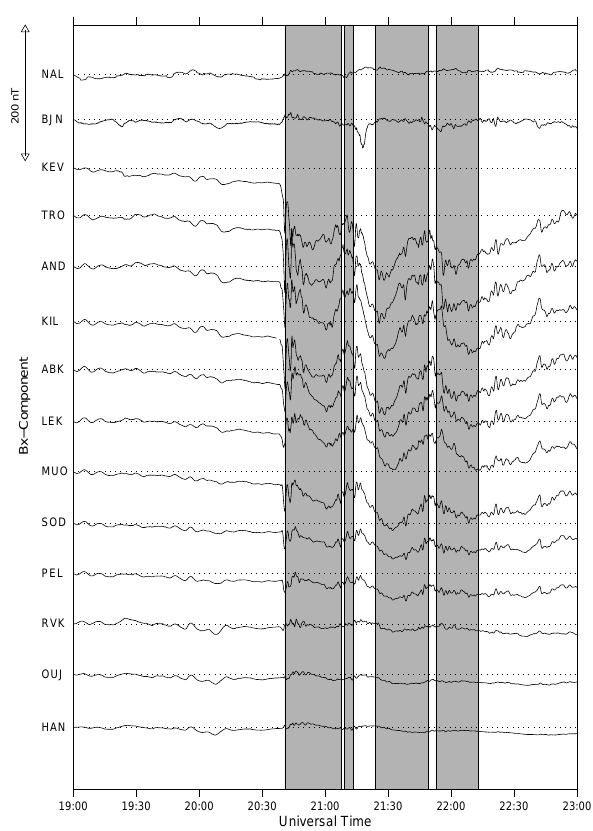
Fig. 5. Selected B x -component magnetograms from the IMAGE network. Periods during which Cluster is in the lobe have been shaded. Note that only s/c 2 is in the plasma sheet from 21:49– 21:53 UT.